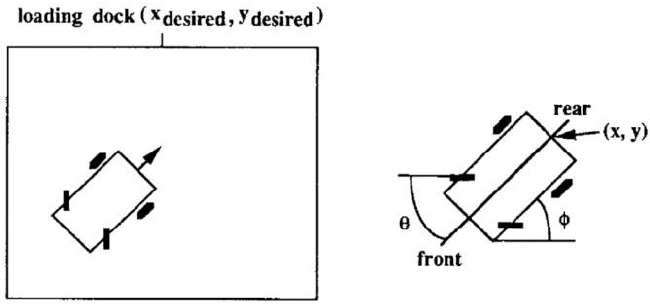
Table 3. Resources requirements of FNFN implementation for the temperature control.